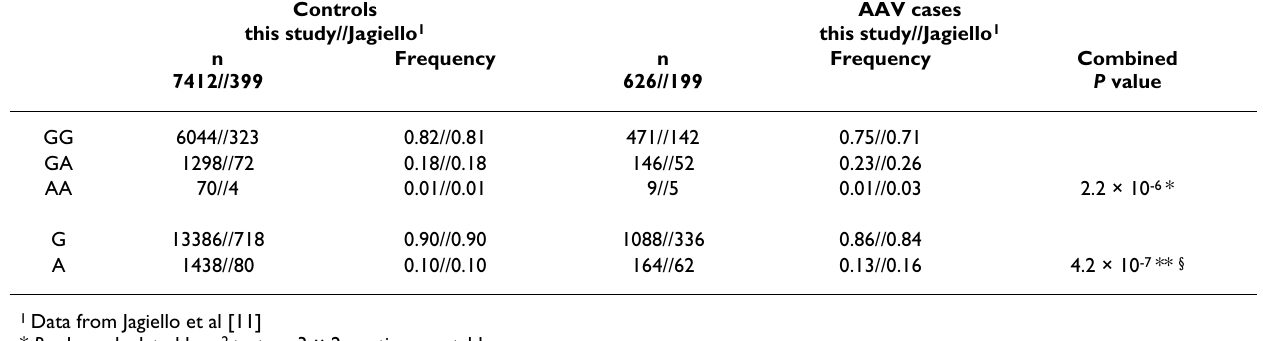
Table 3: Meta-analysis for PTPN22 rs2476601 in